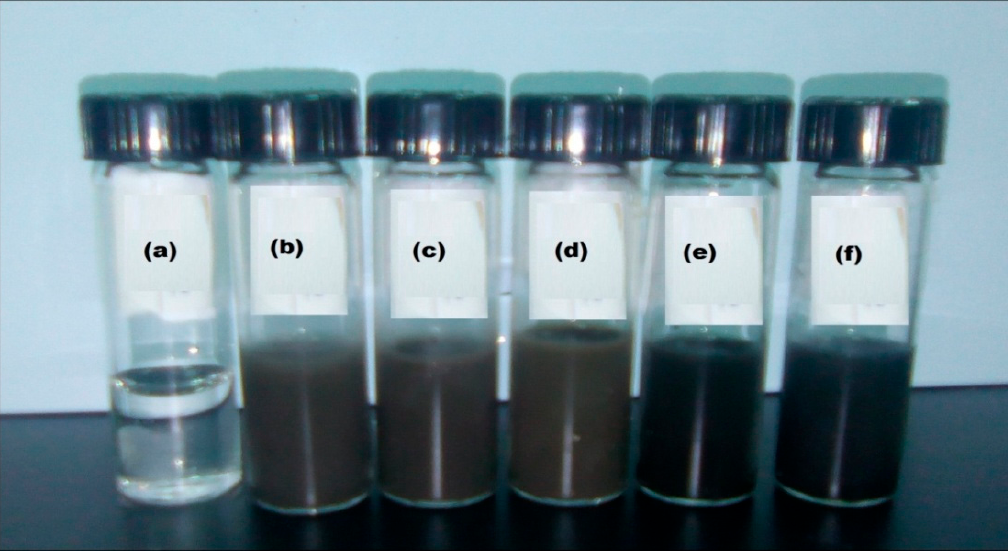
Figure 1. Characteristic changes in the color of pullulan solutions before and after irradiation: Pullulan/Ag ion, after 0, 12, 24, 48, 64, 96 h (a–f, respectively).